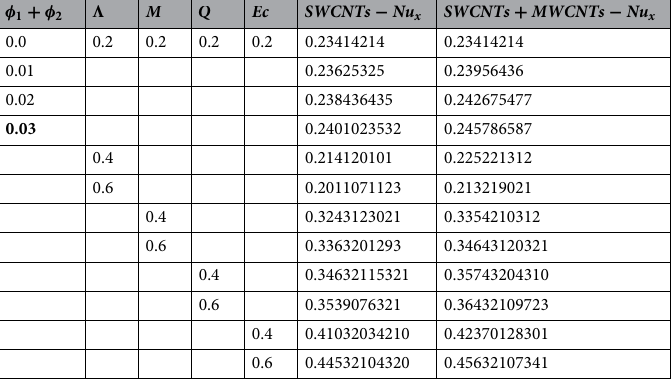
0.5 Table 2. Nusselt number Nu x Re − x versus various parameters for Blood-based hybrid nanofluid.